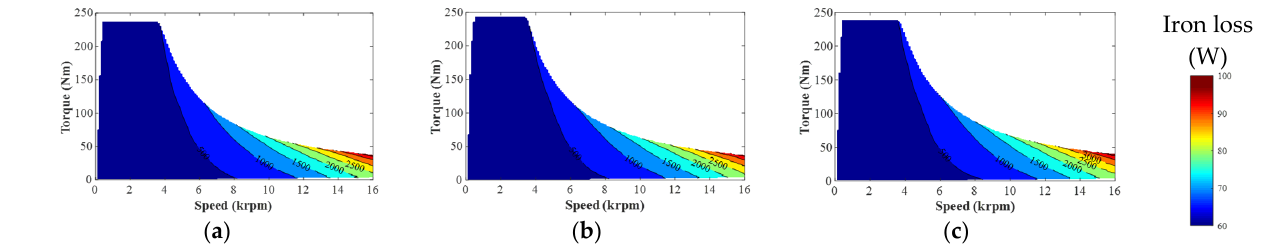
( c ) Figure 34. Efficiency maps of different winding configurations: ( a ) ORG; ( b ) DTP-SF; ( c ) DTP-DS. The differences between the efficiency maps of DTP and ORG winding configura- tions are shown in Figure 35. For the DTP-SF winding configuration, the difference is neg- ative in the most efficient region. However, for the DTP-DS winding configuration, the difference is positive in most of the whole range. It indicates that the efficiency of the DTP- SF winding configuration is lower than that of the ORG counterpart in most conditions, while the DTP-DS winding configuration can improve efficiency over most of the whole